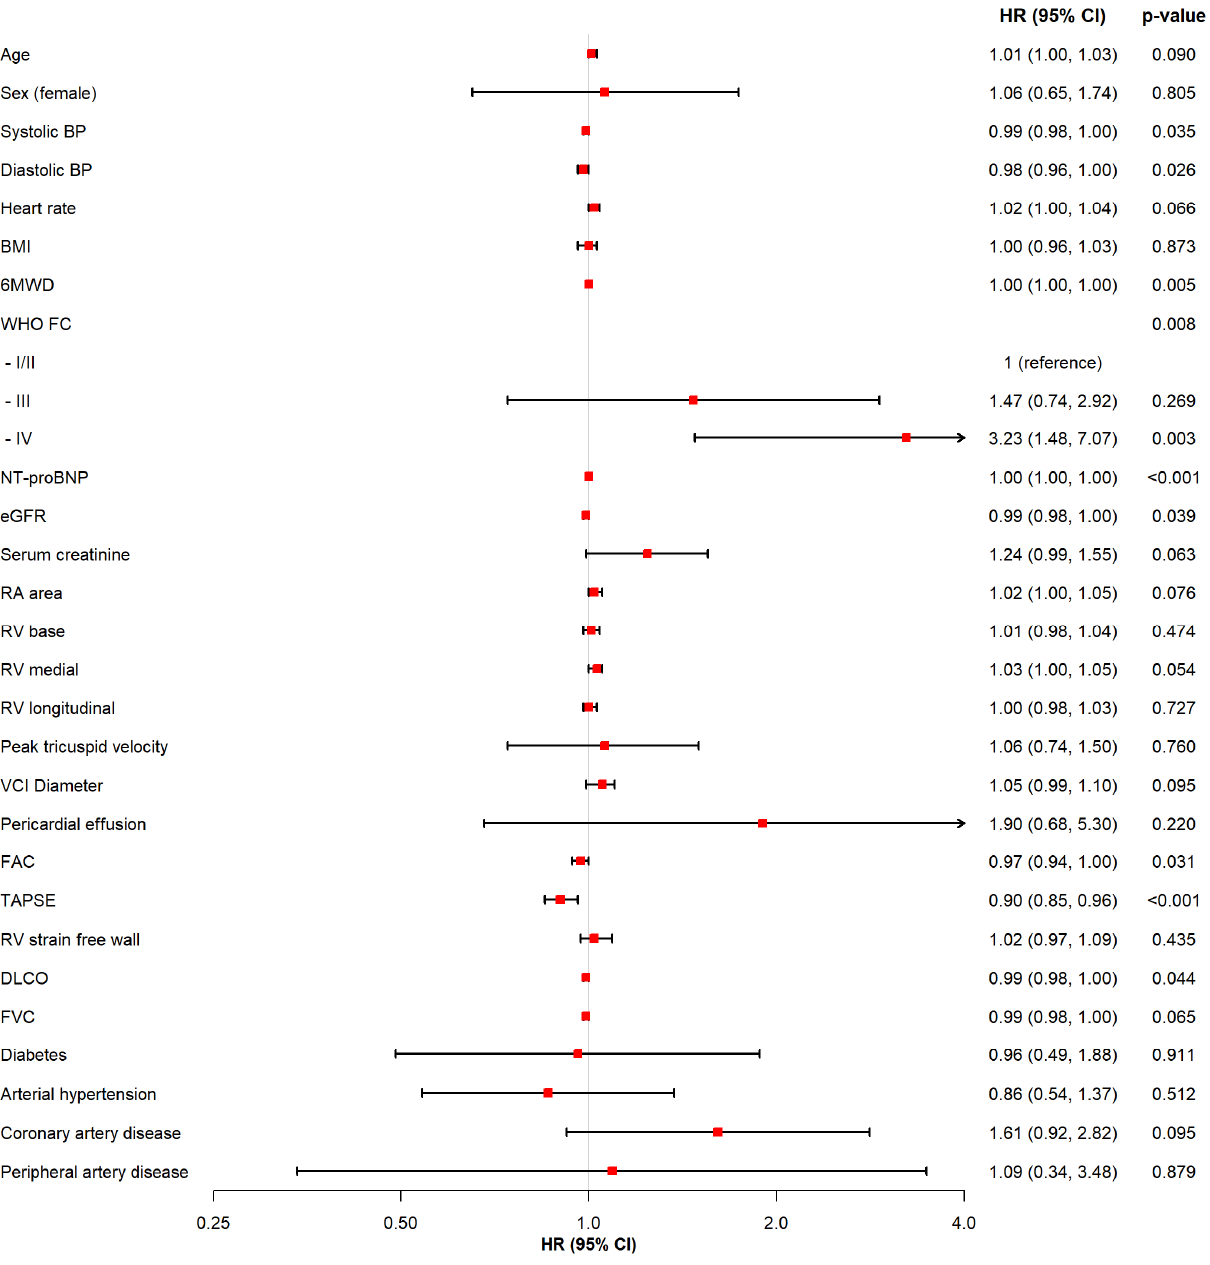
Figure 1. Predictors of death or lung transplantation in univariable Cox regression analyses. Legend: This figure displays the association of each variable with all-cause mortality and lung transplantation based on univariable Cox regression analyses. Abbreviations: HR = Hazard Ratio, CI = Confidence Interval, No. = Number, BP = blood pressure, BMI = body-mass-index, 6MWD = 6-min walk distance, FC = functional class, NT-proBNP = N-terminal-pro hormone brain peptide, eGFR = estimated glomerular filtration rate, RA = right atrial, RV = right ventricular, VCI = vena cava inferior, FAC = fractional area change, TAPSE = tricuspid annular plane systolic excursion, DLCO = diffusing capacity of the lungs for carbon monoxide, FVC = forced vital capacity.